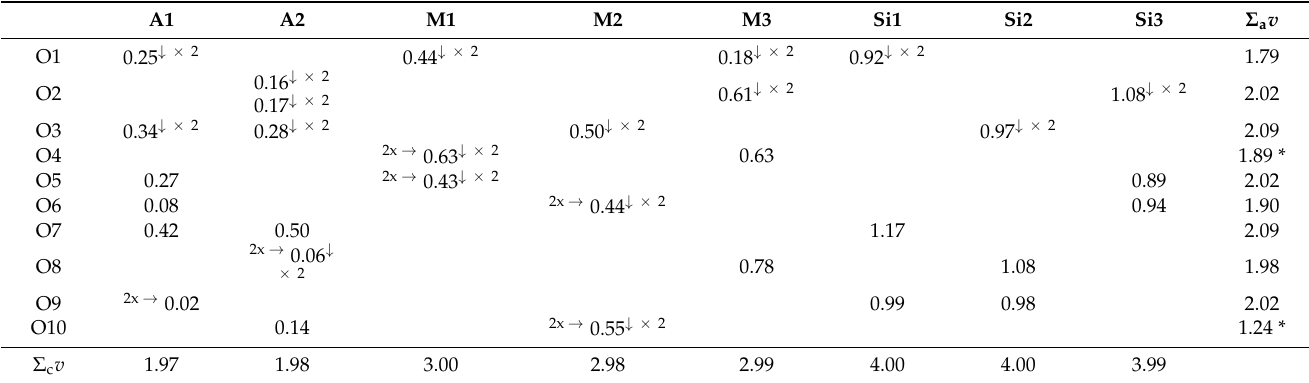
Table 10. Weighted bond-valence balance ( v.u. ) for